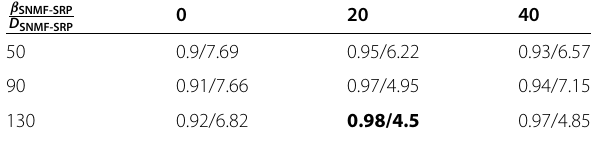
Table 2 F-measure and mean azimuth error (MAE) for the supervised NMF-SRP (SNMF-SRP) for varying D SNMF-SRP and